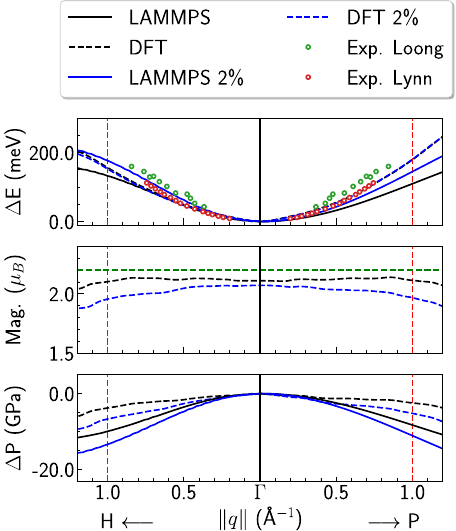
Fig. 5 Spin-spiral calculations. Comparison of spin-spiral results along sections of the Γ H and Γ P high-symmetry lines. The upper plot displays the per-atom energy, the middle one the atomic moment fl uctuations (in Bohr magneton per atom), and on the bottom the evolution of the pressure. The energy and pressure fl uctuations are plotted with respect to the magnetic ground state at the Γ point. The green and red dots represent experimental measurements obtained by Loong et al. 92 and Lynn 93 . In all three plots, the dashed lines correspond to the DFT results, and the continuous lines to our classical model results, whereas the line color (black or blue) corresponds to the lattice compression (0% or 2%, respectively). In the middle plot, the green dashed horizontal line represent the experimental equilibrium value (2.2 μ B per atom), which is the constant value chosen in our model. In all three plots, the red vertical dashed lines are delimiting the q -vectors on which our spin Hamiltonian was